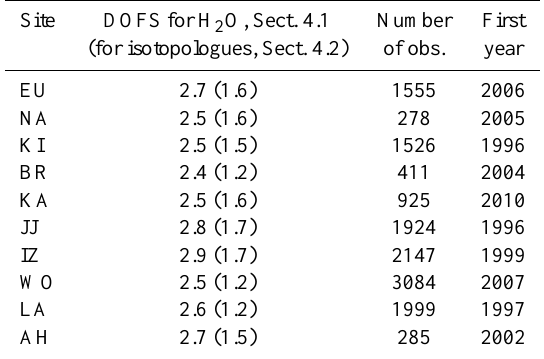
Table 6. Statistics of the DOFS and the current data record for the ten ground-based MUSICA sites. Site DOFS for H 2 O, Sect.